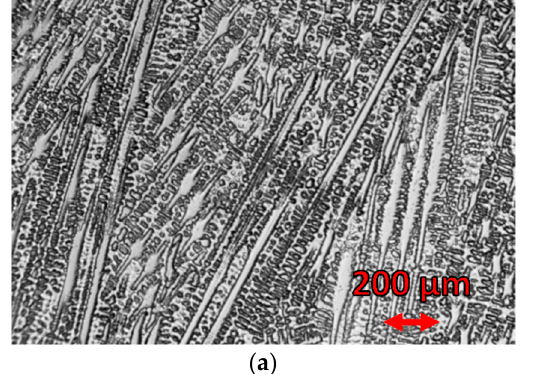
Figure 10. The microstructure of the mixed joint ( a ) central part made of S355J2W+N steel and Alloy 59. ( b ) enlargement of the selected area shown in ( a ).